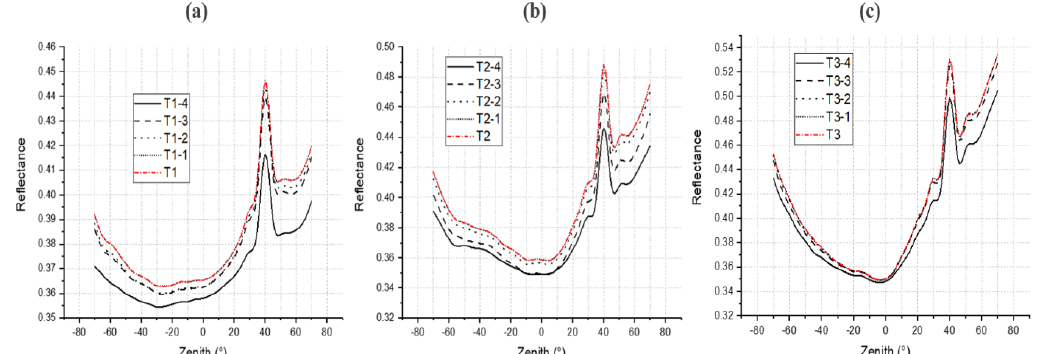
Figure 15. Reflectance at the wavelength 850 nm for different zenith angles, ( a ) first stage, ( b ) second stage, and ( c ) last